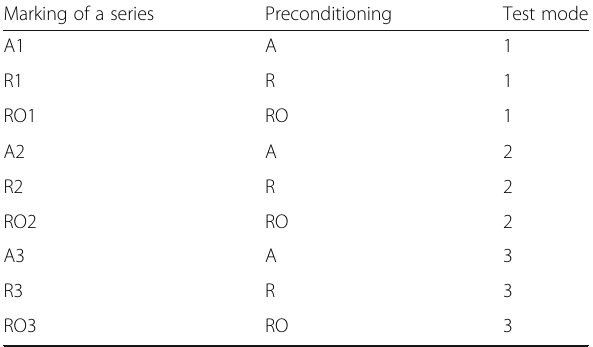
Table 1 The treatment and test regimes